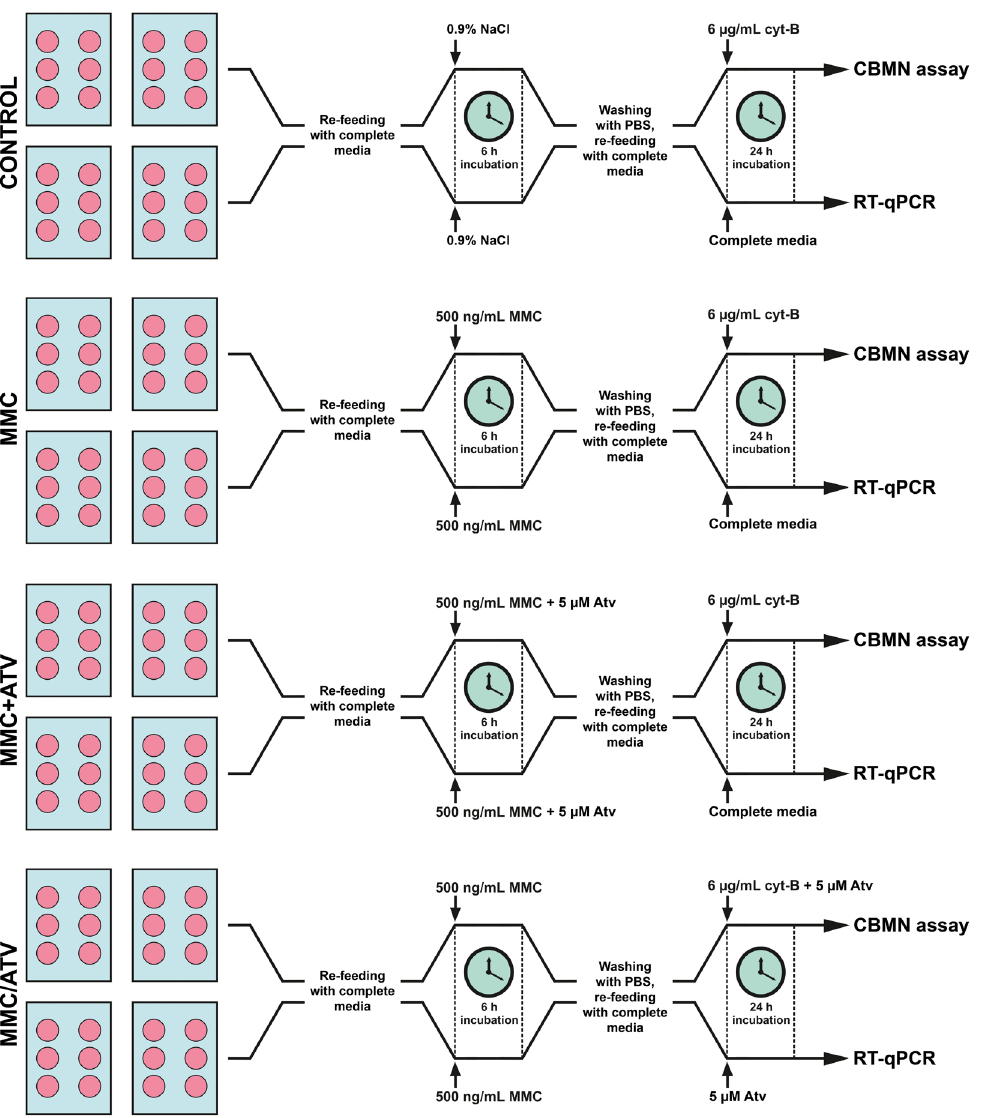
Figure 4. Experimental design of the study (PBS, phosphate buffered saline; cyt-B, cytochalasin B; CBMN assay, cytokinesis-block micronucleus assay; RT-qPCR, quantitative reverse transcription polymerase chain reaction; MMC, mitomycin C; Atv, atorvastatin).